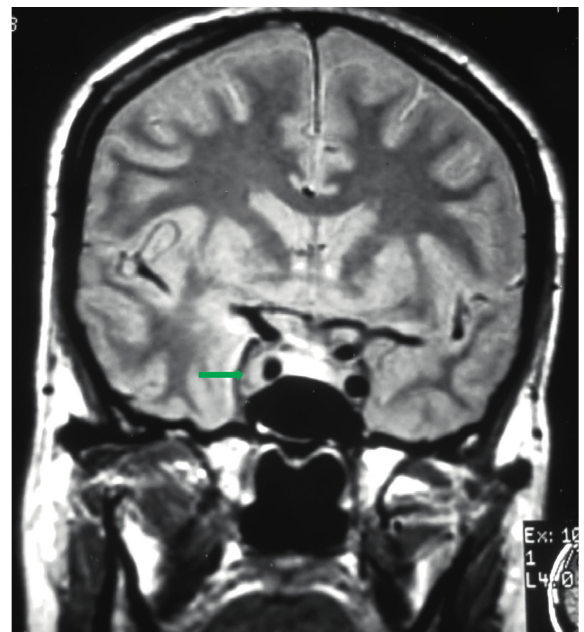
Figure 3: Coronal sequence, in T2, showing expansive, extra-axial, parasellar lesion, involving the right cavernous sinus and the carotid, without compromising their diameters (red arrow) with intermediate signal (green arrow).